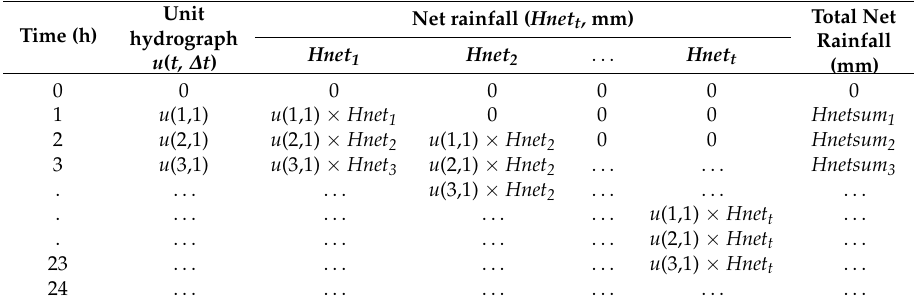
Figure 5. Calculation method for the parameter values of n and K , where F represents the catchment area, km 2 ; J represents the slope of the main channel; Hnetmax 2 represents the maximum net rainfall in 2 h; l and g represent parameters of the design floods; ic represents the critical rainfall intensity; m 1 represents hysteresis, which is equivalent to the time interval between the centroid of the net rainfall process and the centroid of the runoff process; m 2 represents the measurement parameter reflecting the instantaneous unit hydrograph shape; and n is the parameters used in calculating the instantaneous unit hydrograph; and K represents the parameter about the time of concentration. Table 2. Method of calculation of the sum of net rainfall in each